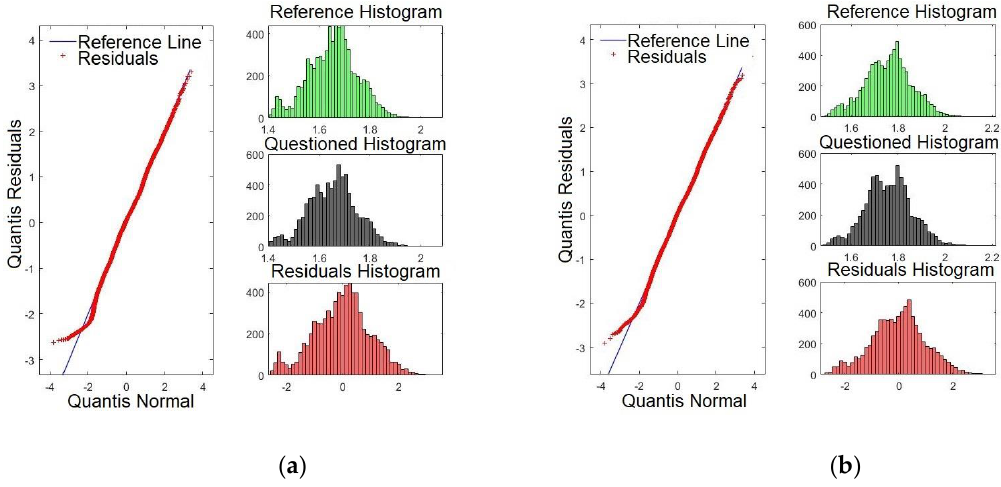
Figure 9. Q-Q plot of the formants comparing the confronted with the reference audios: (a) formant F15 and (b) formant F16 .